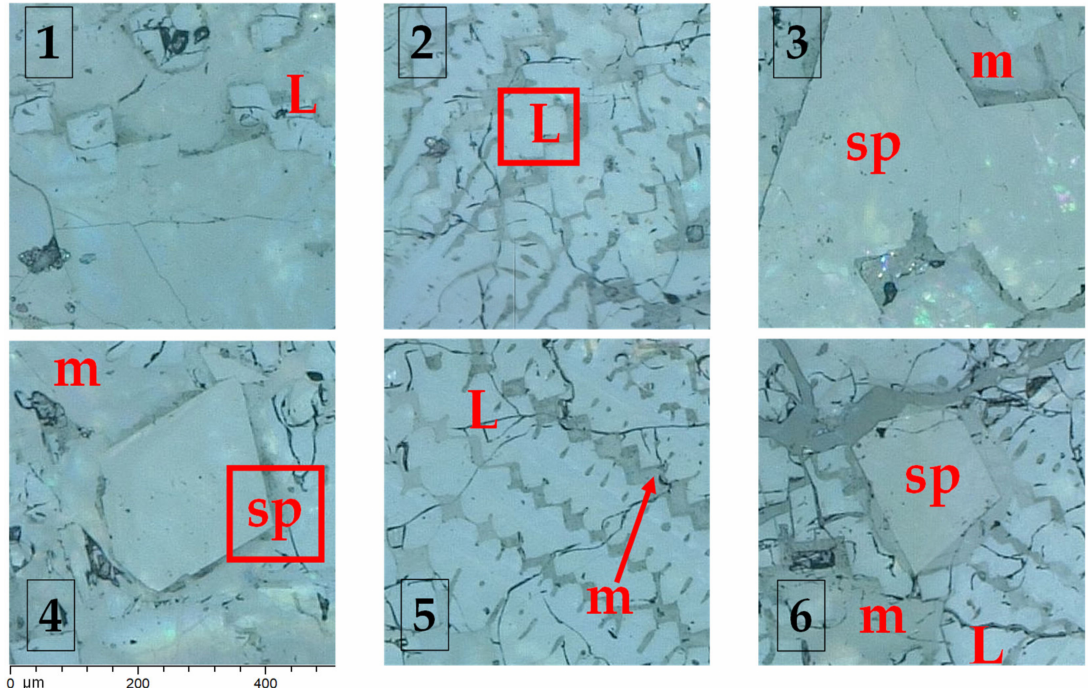
Figure 1. Overview optical microscopy images of six different positions of the sample. L: Li-aluminate, m: matrix (MCAS, sp: spinel (ss). Red squares: regions of interest (ROI) (see